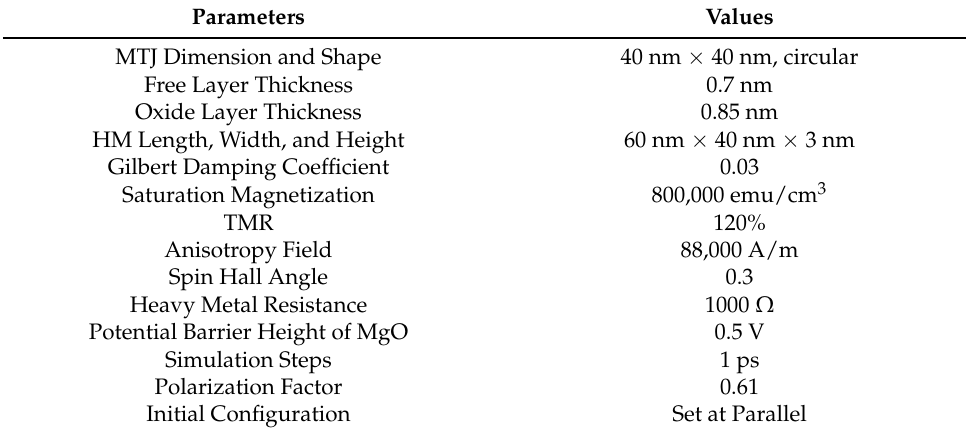
Table 1. SOT-assisted MTJ parameters set during electrical